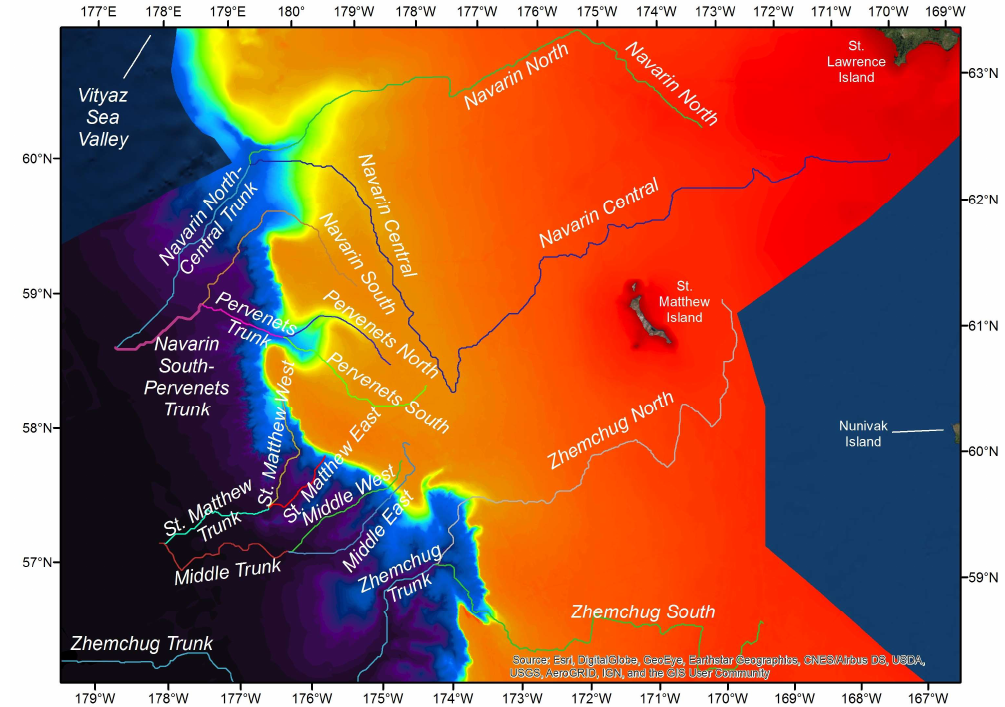
Figure 8. Thalwegs of the Navarin Canyon area of the eastern Bering Sea slope. Table 3. Navarin Canyon names and metrics described from south to north.